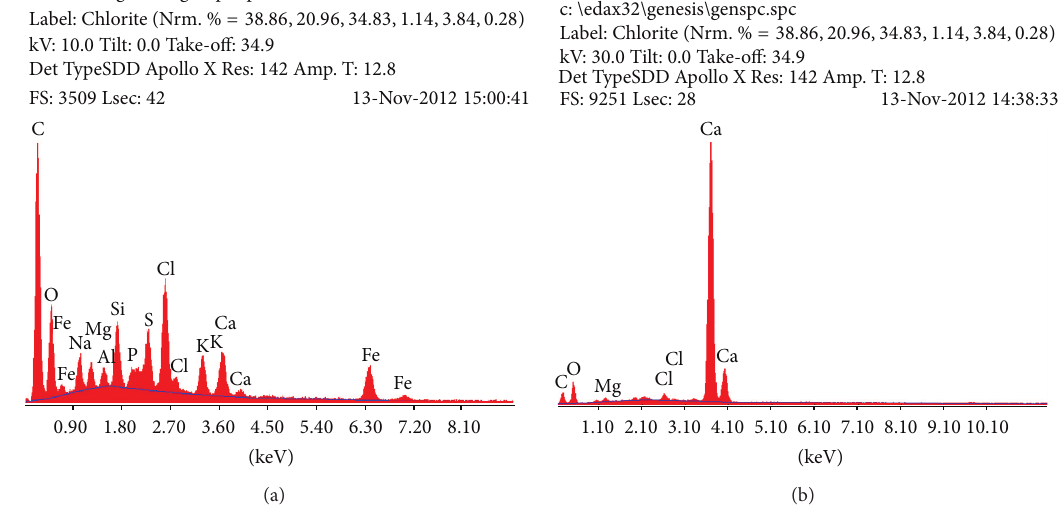
Figure 5: EDS spectrums of membrane (a) and spacer (b) surfaces.